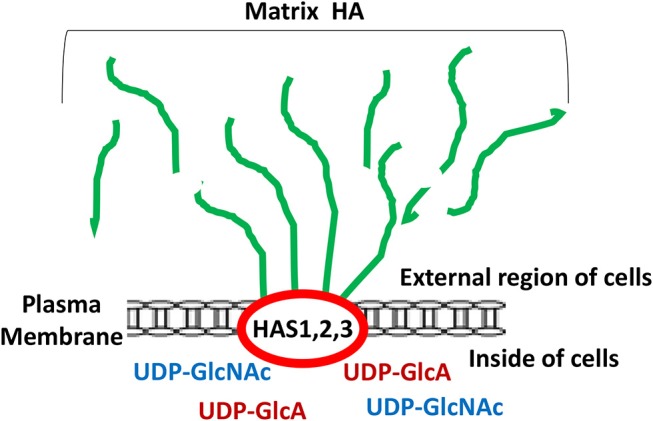
Illustration of matrix hyaluronan (HA) structure regulated by HA synthases (HAS1, HAS2, and HAS3). Green lines represent matrix HA which is made by HAS1, HAS2, and HAS3 followed by being secreted into the external region of the cells.